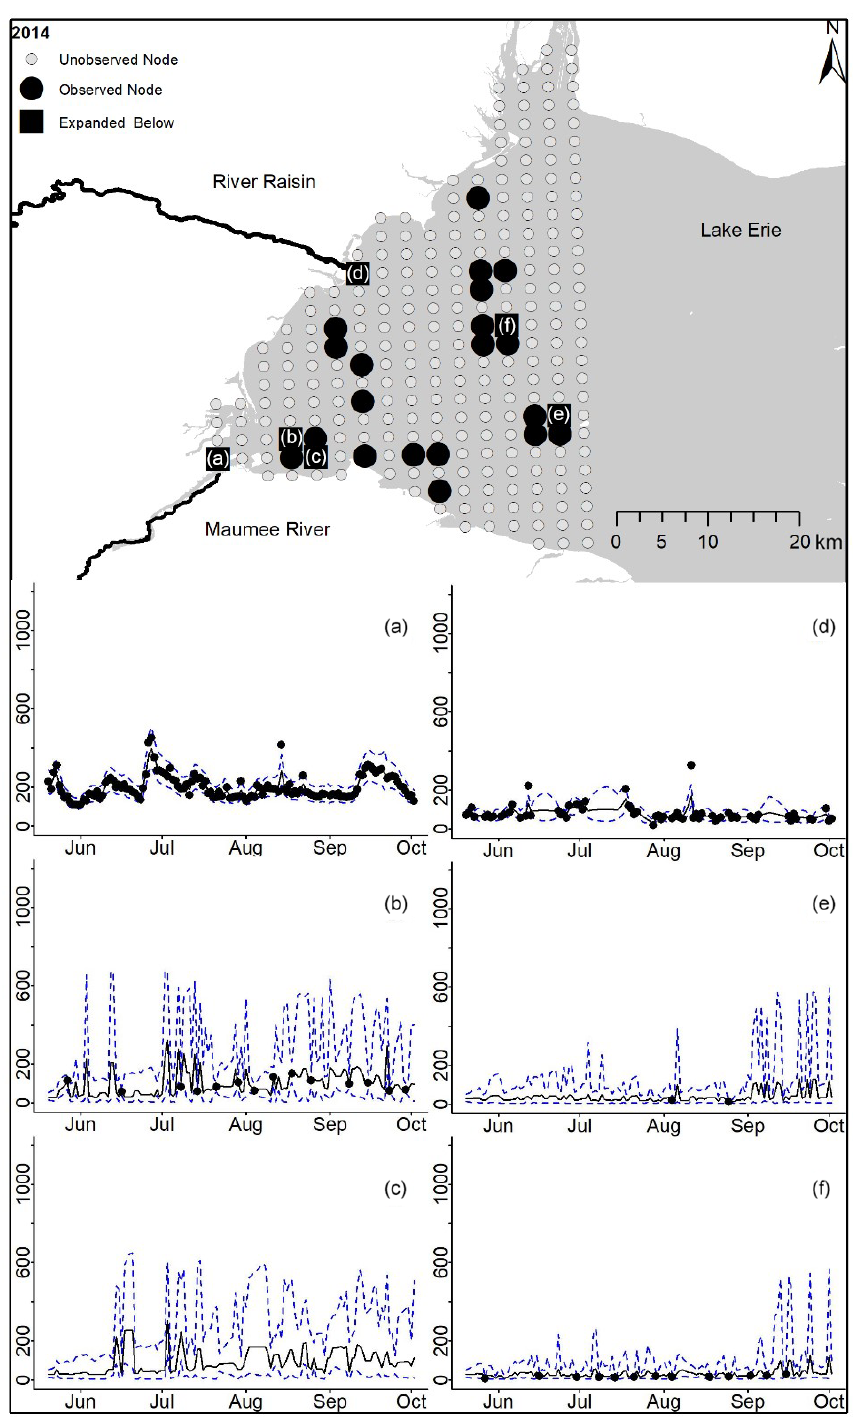
Figure D7. For 2014 the total phosphorus concentrations (µgL − 1 ) at observed and unobserved nodes were estimated from the model posterior samples. Mean (solid black line) and 95%PI (dashed blue line) for the model posterior samples of each node at every day for (a) the Maumee River, (b, c, e, f) western Lake Erie nodes, and (d) the Raisin